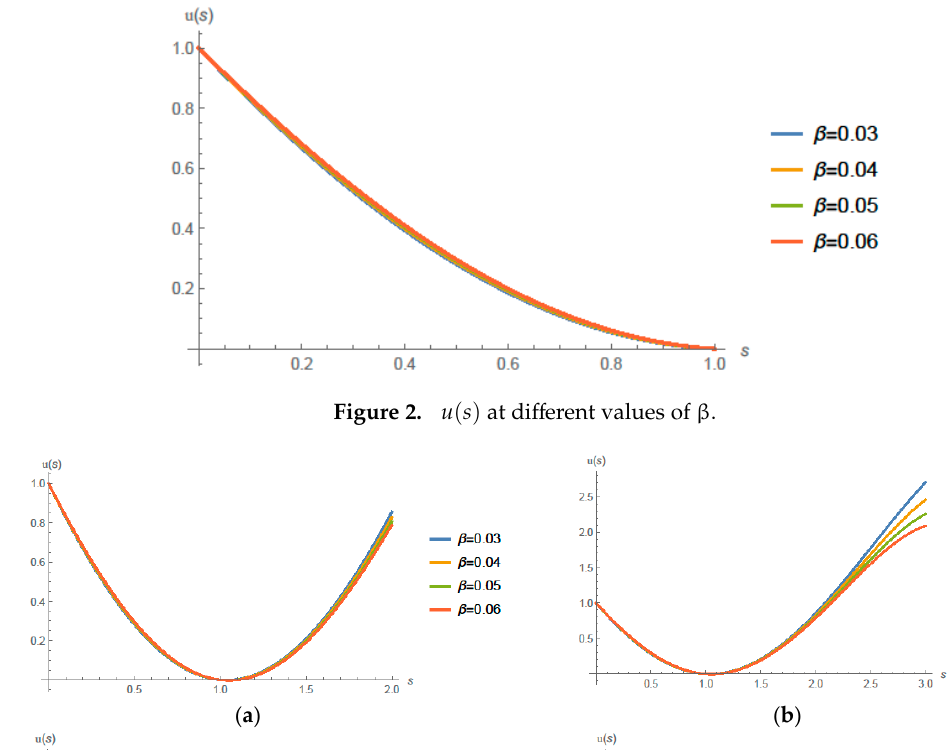
Table 2. Values of 𝑃 (cid:3045) and 𝐶 (cid:2869)